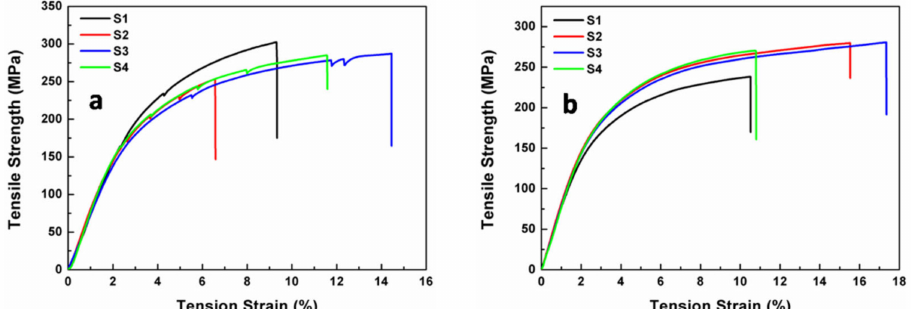
Figure 11. Mechanical properties of PI membranes ( a ) before and ( b ) after coated with SiO 2 antire- flective membrane. Each sample has been tested for four times to guarantee the accuracy.